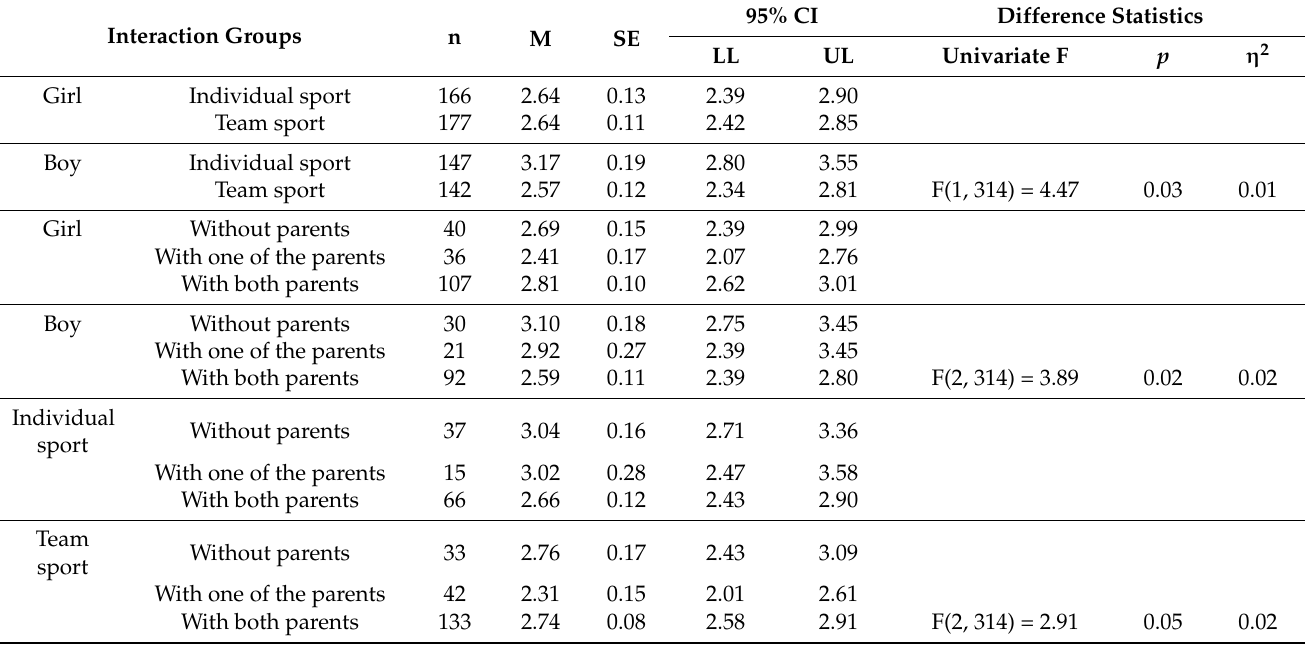
Table 4. Interactions of interest for the PNPCAP negative